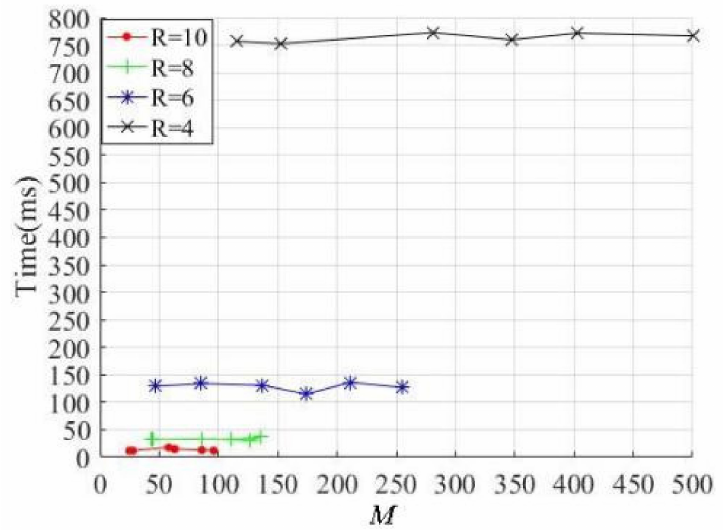
Figure 10. The superpixel segmentation time-consuming with different values of R